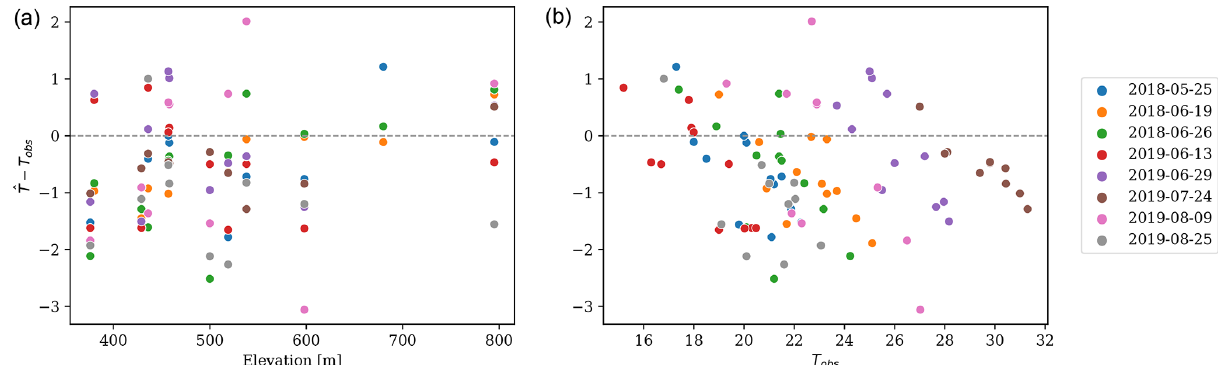
Figure 4. Scatterplot of the differences between the T air simulated by the InVEST urban cooling model and the values observed at the monitoring stations ( y axis) against the elevation of the monitoring station ( x axis of panel a ) and the observed T obs ( x axis of panel b ), colored by the sample date.